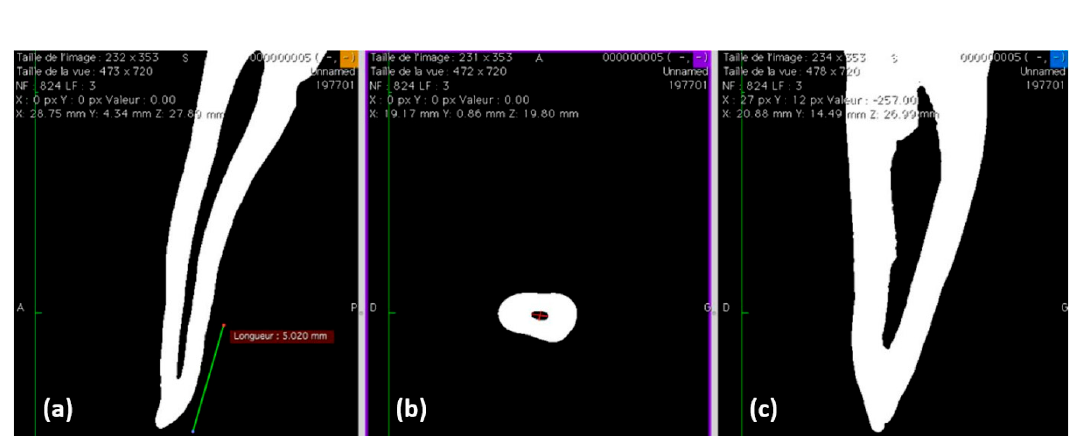
Figure 1. ( a – c ) Cone-beam computed tomography (CBCT) analysis for teeth selection to ensure the following criteria: single canal, long/short diameter (ratio > 2), and root curvature ( ≤ 20°). Cusps were flattened using silicon carbide grit papers (320 grit) mounted on a rotating polishing machine (Escil, Chassieu, France) to obtain a stable reference point and to standardize root canal length at 21 ± 1 mm.